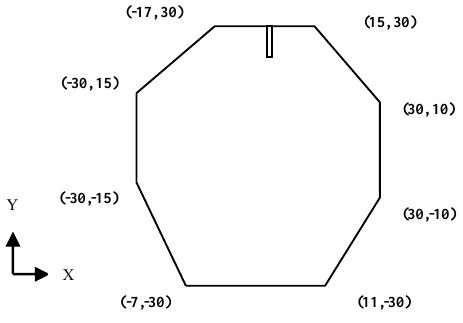
Fig. 1.11 Polygon shaped patch Antenna 3-Topology